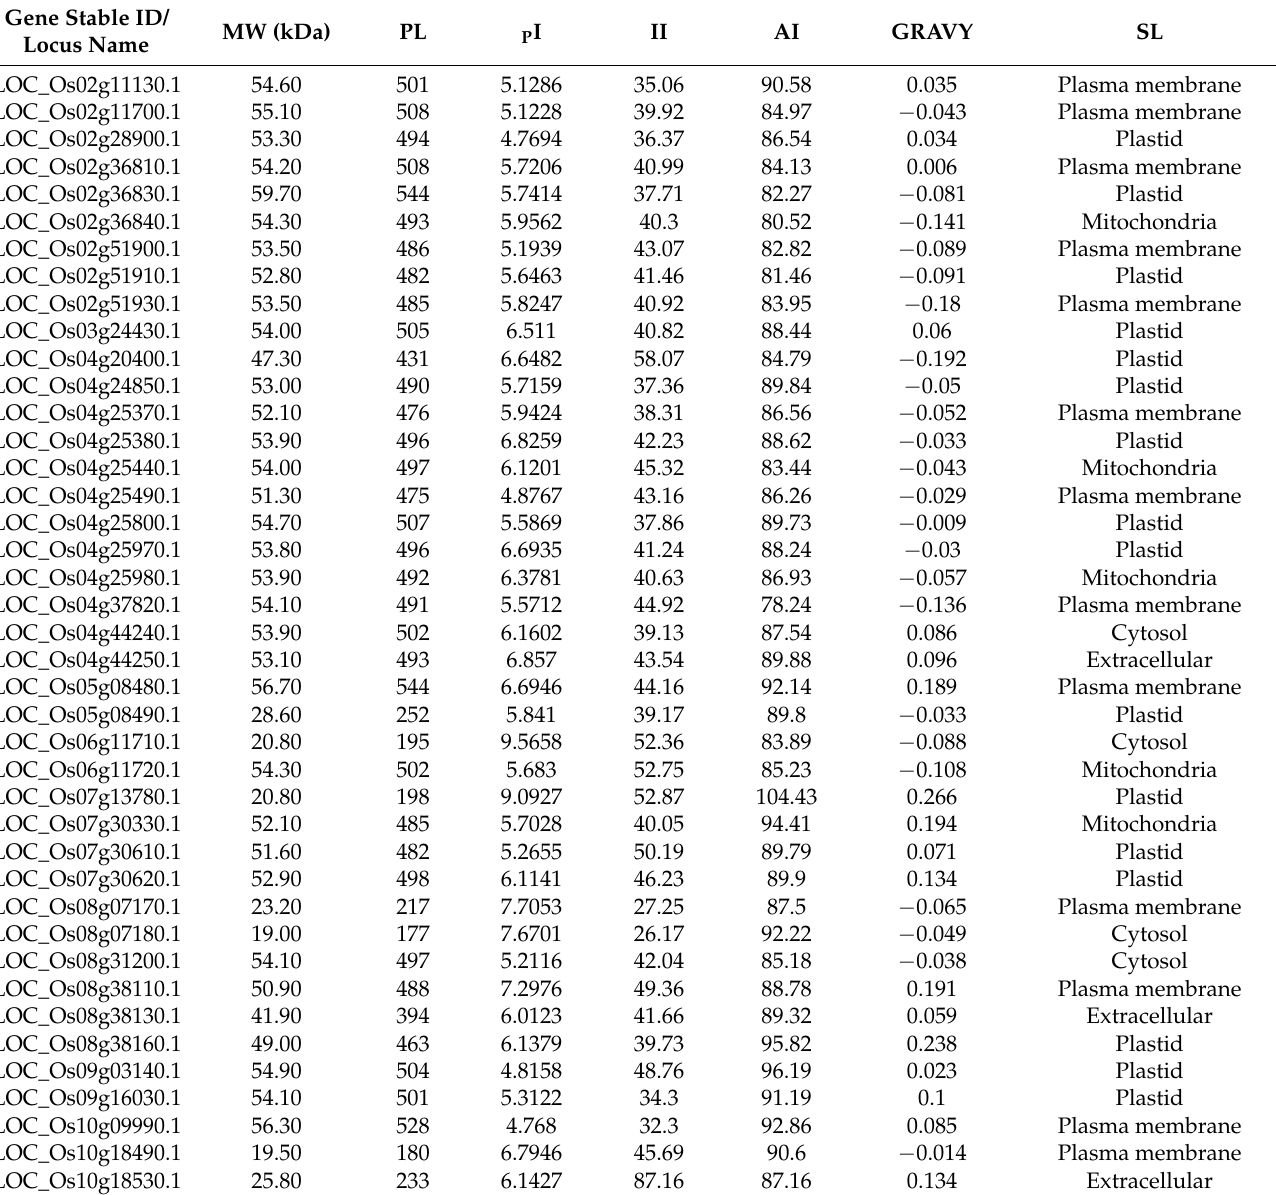
Table 1. List of putative cytokinin-O-glucosyltransferases genes deduced from rice genomic